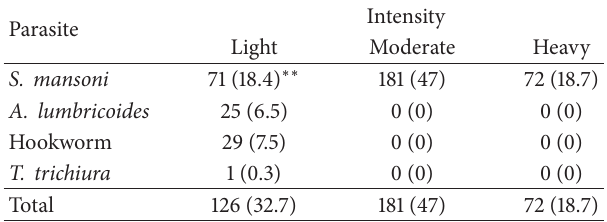
Table 3: The intensity of Schistosoma mansoni and common intestinal helminths using Kato-thick smear technique among Sanja General Elementary School children, northwest Ethiopia,